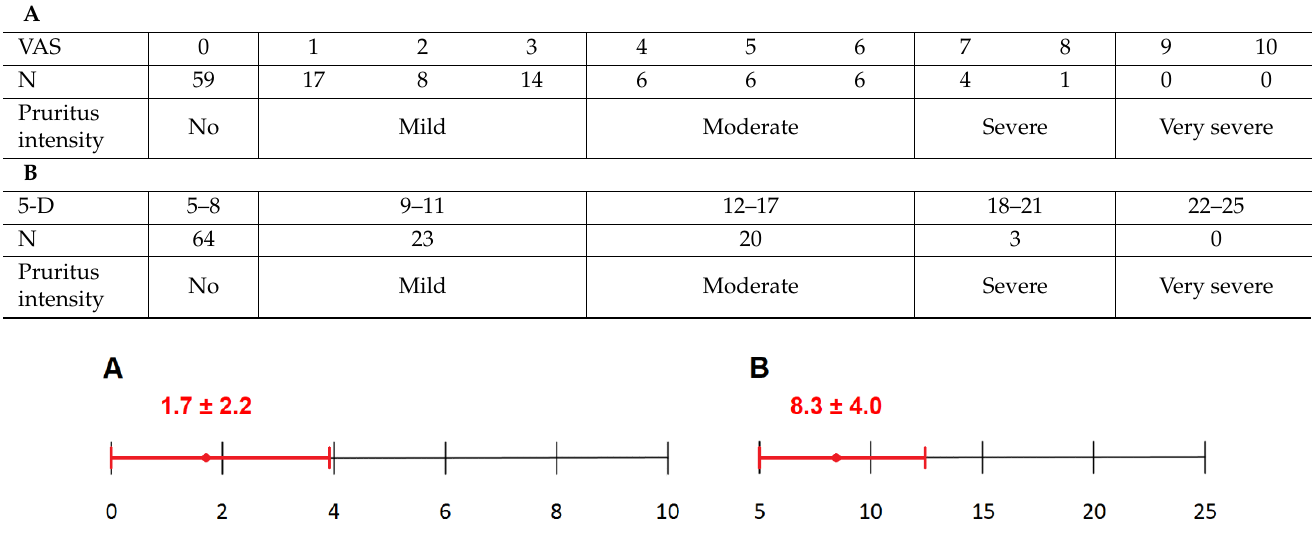
Figure 2. ( A ) Visual analogue scale with mean ± SD. ( B ) 5-D itch scale with mean ± SD (indicated in red font).